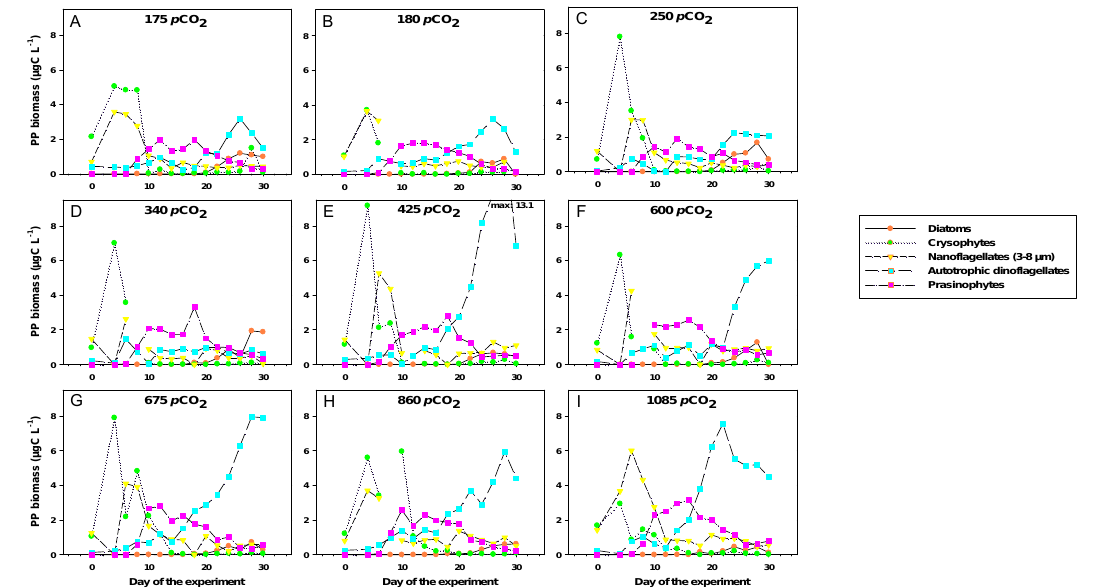
Fig. 2. Phytoplankton (PP) biomass (µgCL − 1 ) of different taxonomic groups (orange circles: diatoms; green circles: chrysophytes; yellow Fig. 2: Phytoplankton (PP) biomass (µg C L -1 ) of different taxonomic groups (orange circles: Diatoms; green circles: Crysophytes; yellow triangles: triangles: flagellates (3–8µm); blue circles: autotrophic dinoflagellates (mainly Heterocapsa rotundata ); and pink squares: prasinophytes) in Flagellates (3-8 µm); blue circles: Autotrophic dinoflagellates (mainly Heterocapsa rotundata ) and pink squares: Prasinophytes) in the different the different p CO 2 treatments ( p CO 2 of 175 (A) , 180 (B) , 250 (C) , 340 (D) , 425 (E) , 600 (F) , 675 (G) , 860 (H) and 1085 (I) ). p CO 2 treatments ( p CO 2 of 175 (A), 180 (B), 250 (C), 340 (D), 425 (E), 600 (F), 675 (G), 860 (H) and 1085 (I)).